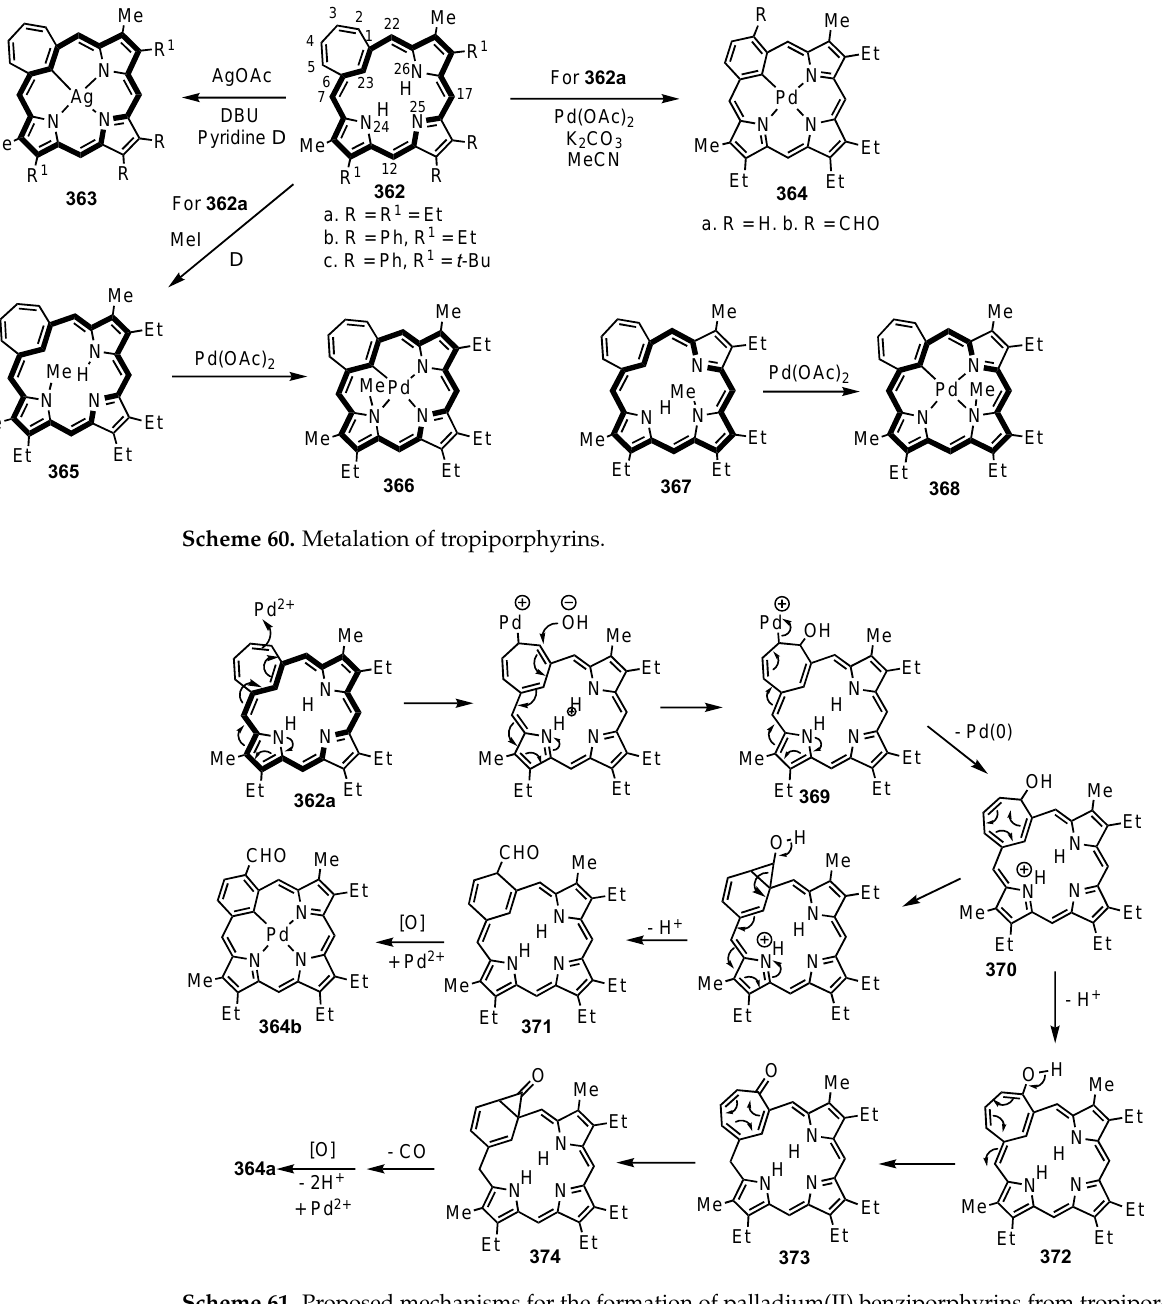
Scheme 61. Proposed mechanisms for the formation of palladium(II) benziporphyrins from tropipor-